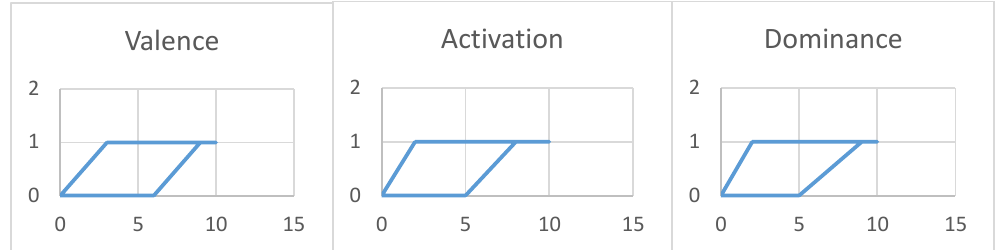
Fig. 6. The FOU of Ihere (Shame) for dimensions valence, activation and